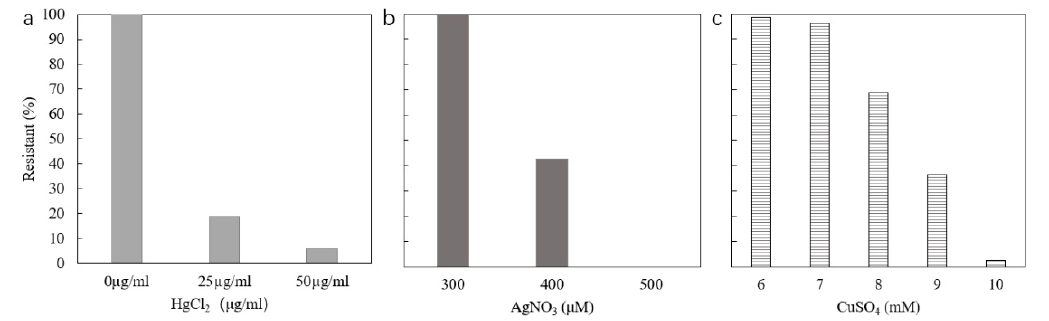
Figure 3. Metal phenotypic resistances of E. coli isolates. ( a ) E. coli strain J53 was completely inhibited at 25 μ g/mL HgCl 2 ; ( b ) silver resistance, E. coli strain J53 was completely inhibited at 400 μ M AgNO 3